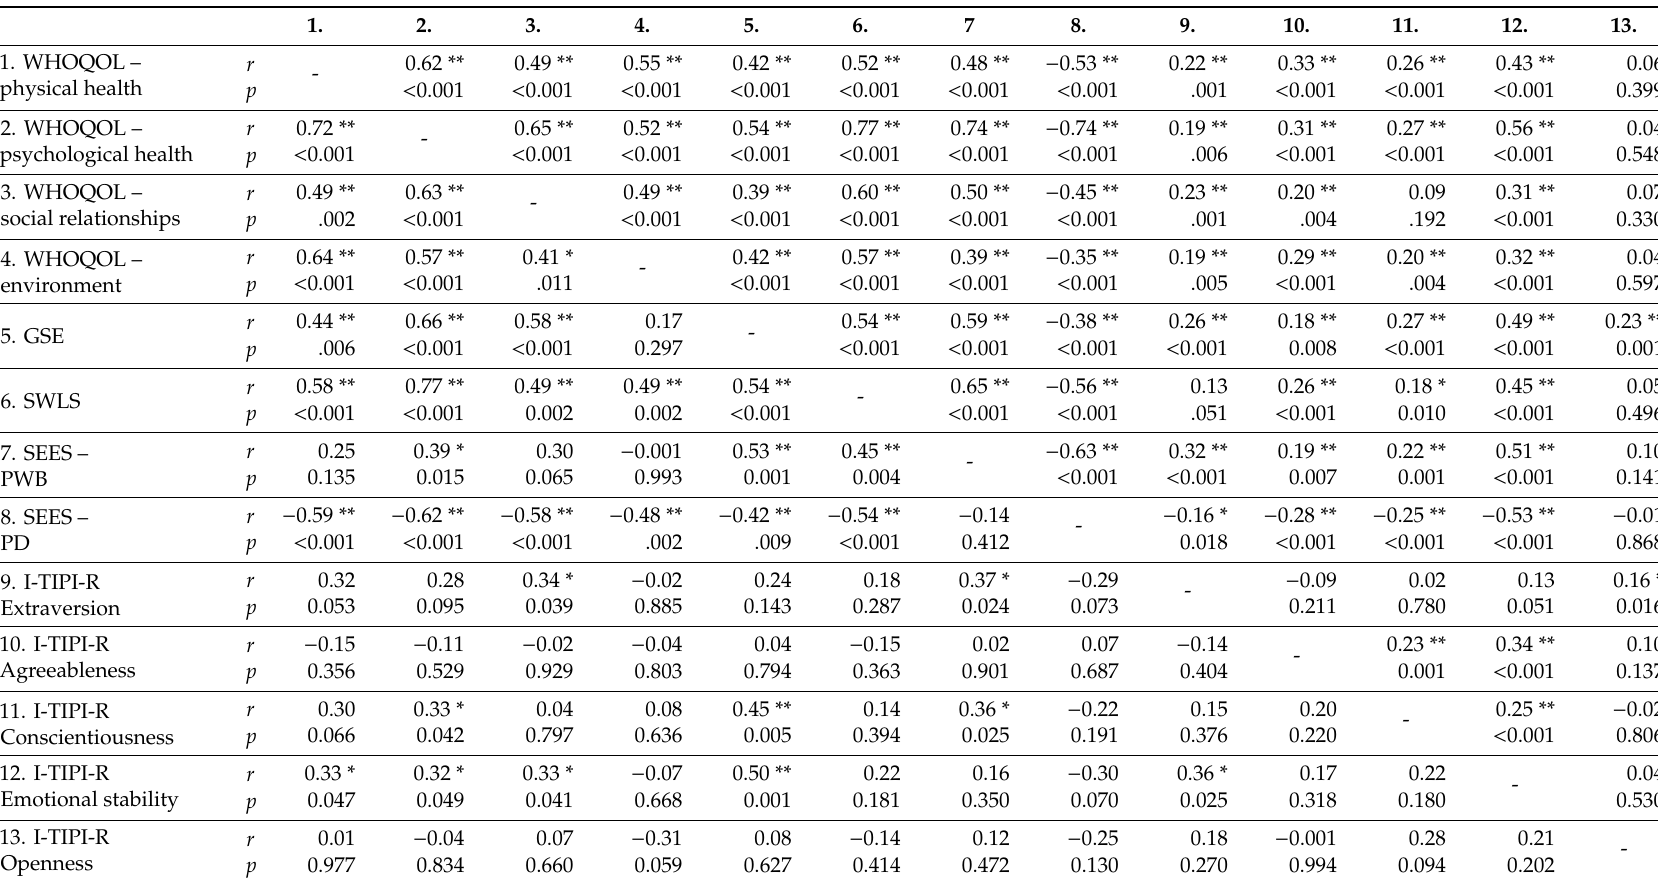
Table 4. Pearson’s r coe ffi cients between all scales calculated for participants practicing sports: below the diagonal AD group ( n = 38), above the diagonal TD group ( n =